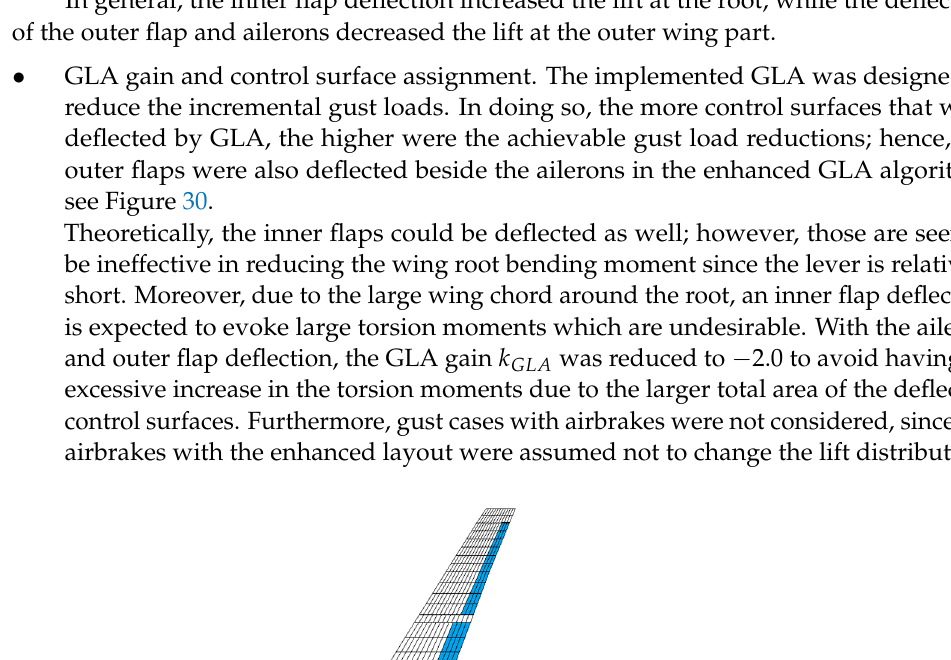
Figure 30. Deflected control surfaces using the enhanced GLA algorithm.